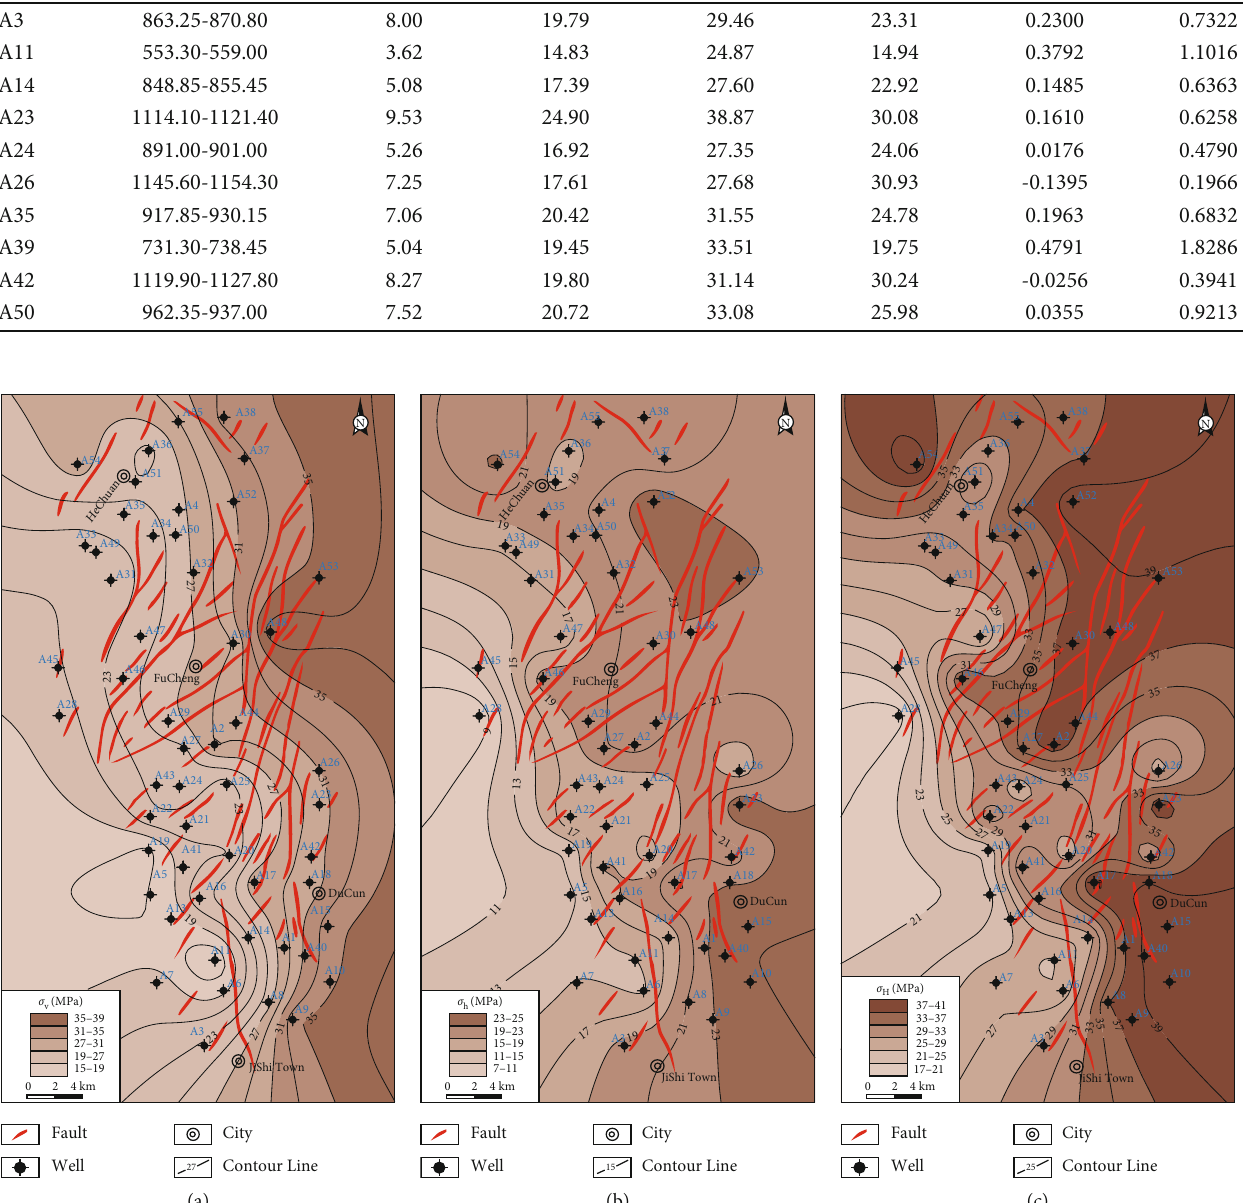
Figure 8: Distribution of geostress in Anze Block. (a) Vertical stresses, (b) minimum horizontal principal stresses, and (c) maximum horizontal principal